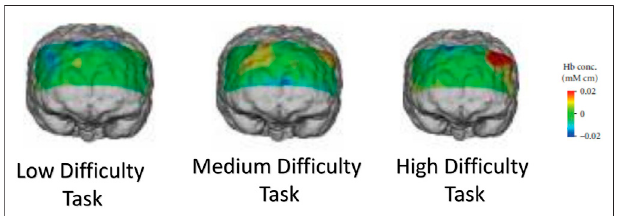
FIGURE 1 | Functional brain imaging by fNIRS obtained while a subject was performing low, medium and high dif fi culty tasks during driving (Tsunashima and Yanagisawa,